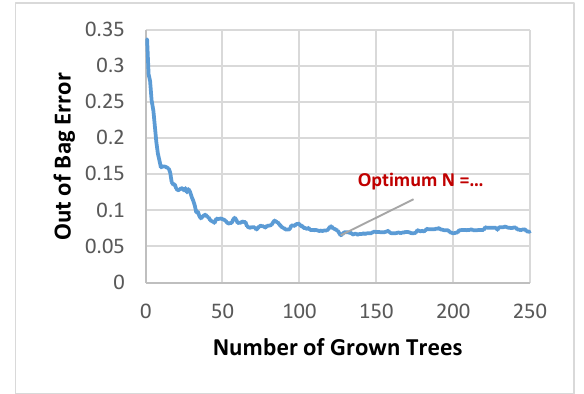
Figure 5. Kappa coefficient against each day for RFC1 classifier.